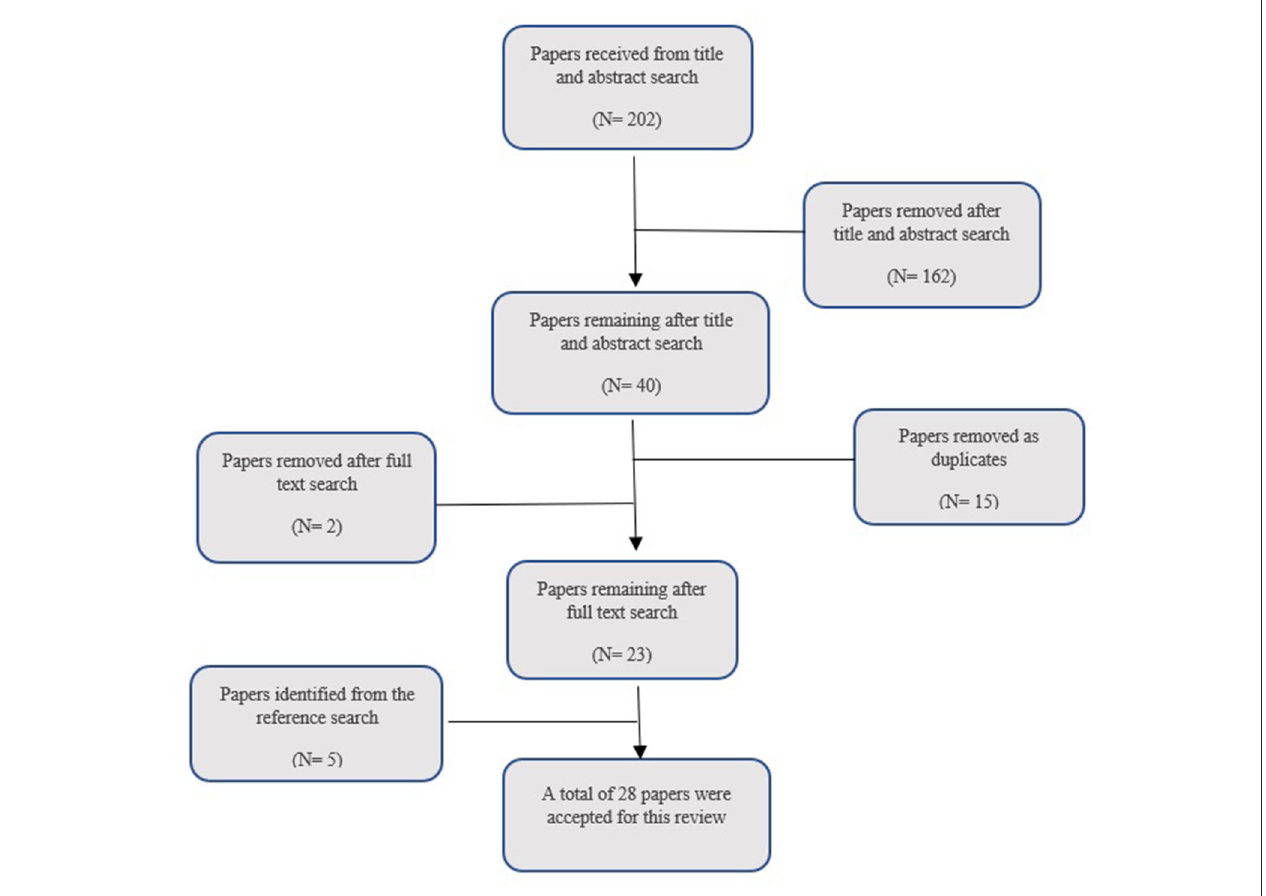
FIGURE 1 | Search strategy used within the systematic search (Moher et al., 2009).